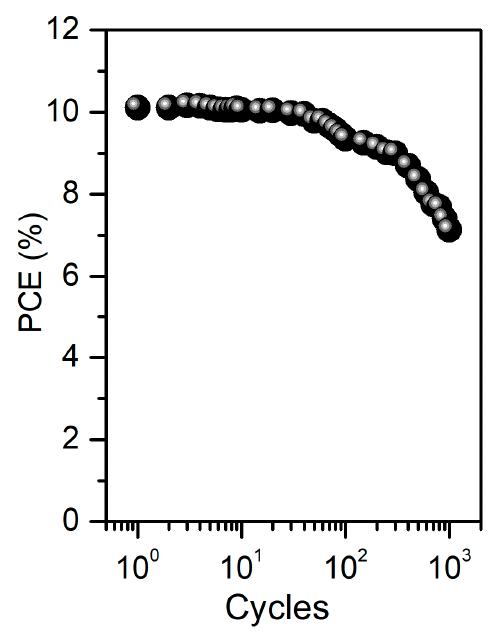
Figure 7. Behavior of photovoltaic PCE under cyclic compression.